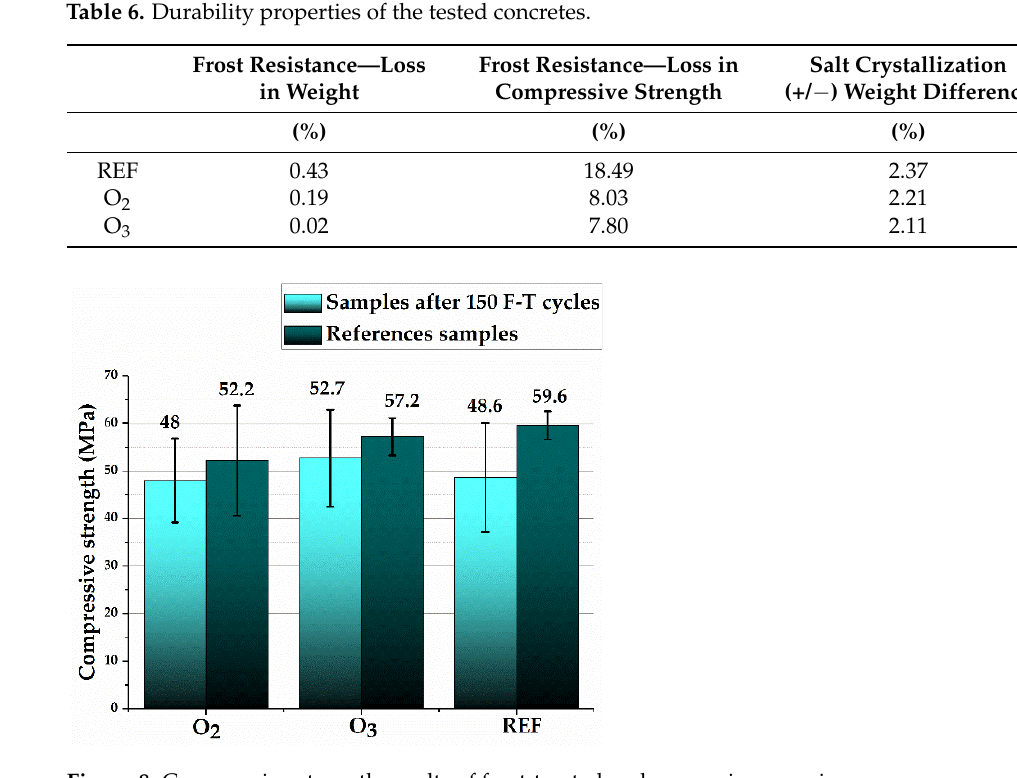
Figure 8. Compressive strength results of frost-treated and comparison specimens.